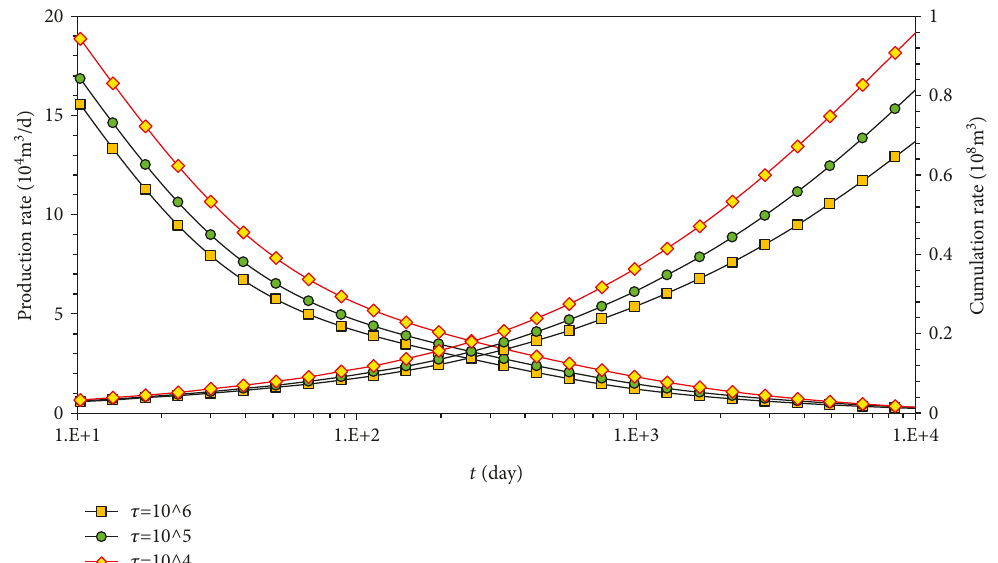
Figure 13: In fl uence of desorption time on well production